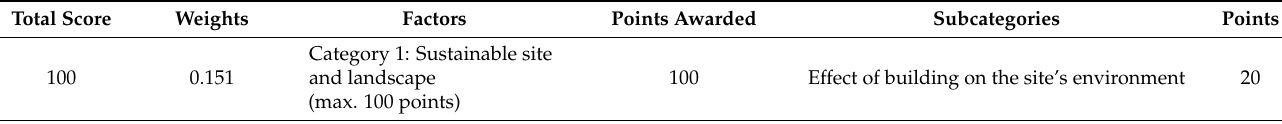
Table 1. Criteria, scores, and weights obtained for the selected factors in green building certification. Total Score